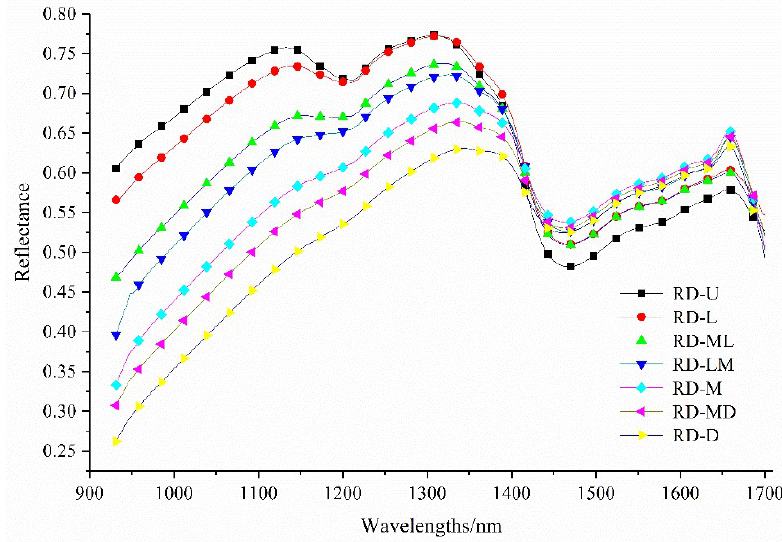
Figure 4. The mean reflectance spectra of the seven roasting degrees of the coffee beans. RD-U: unroasted; RD-L: light; RD-ML: moderately light; RD-LM: light medium; RD-M: medium; RD-MD: moderately dark; and RD-D: dark.